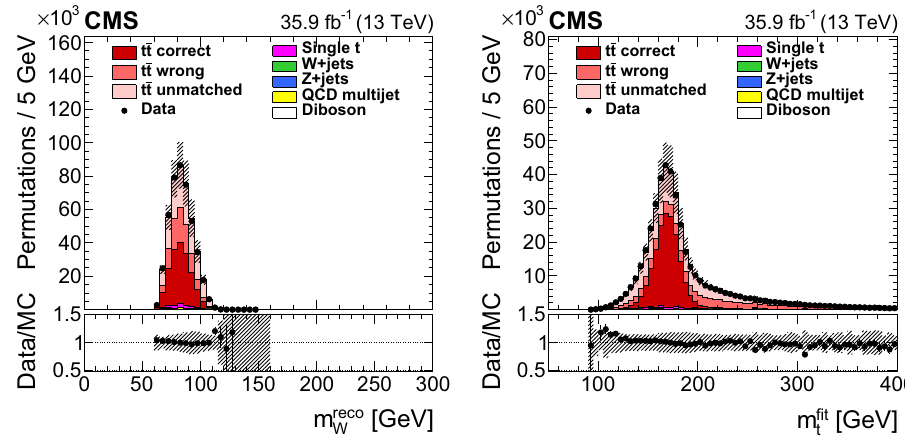
Fig. 2 Reconstructed W boson masses m reco (left) and fitted top W quark masses m fit t (right) after the goodness-of-fit selection and the weighting by P gof . Symbols and patterns are the same as in Fig. 1. The simulations are normalized to the integrated